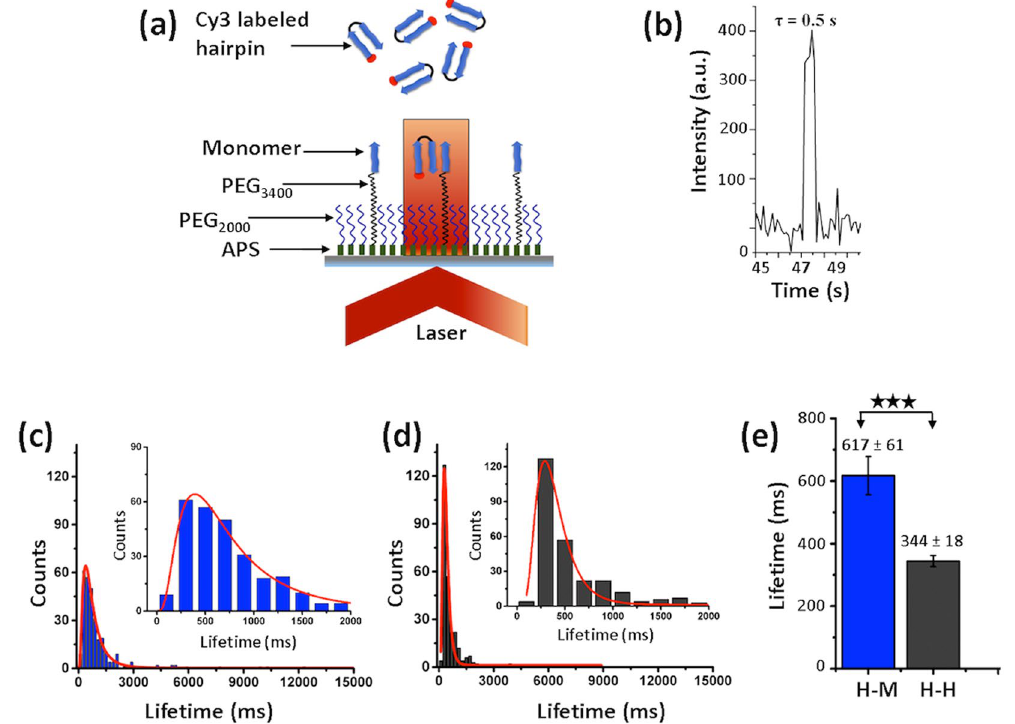
Figure 2. Lifetime measurements for H-M and H-H complexes; ( a ) Schematic representation of TAPIN experimental set up. ( b ) A typical fluorescence time trajectory. ( c ) and ( d ) indicate typical lifetime histograms for H-M (n = 297, blue) and H-H complexes (n = 274, dark grey), respectively. The insets show zoomed histograms in the range of 0–2000 ms. The histograms were fitted with the Lognormal function (red line). ( e ) The average lifetime for the H-M and H-H complexes, extracted from three independent experiments at pH 7.0 and room temperature (mean ± S.D.); the asterisks indicate statistical significance between the two groups using the Kolmogorov-Smirnov test ( *** p < 0.005). n is the number of data